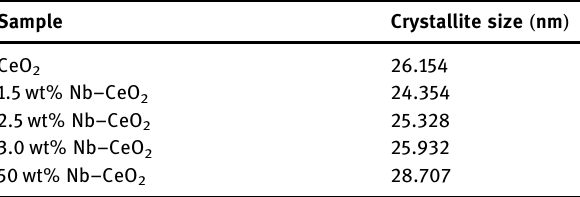
Table 3: Crystallite size of the prepared samples Sample